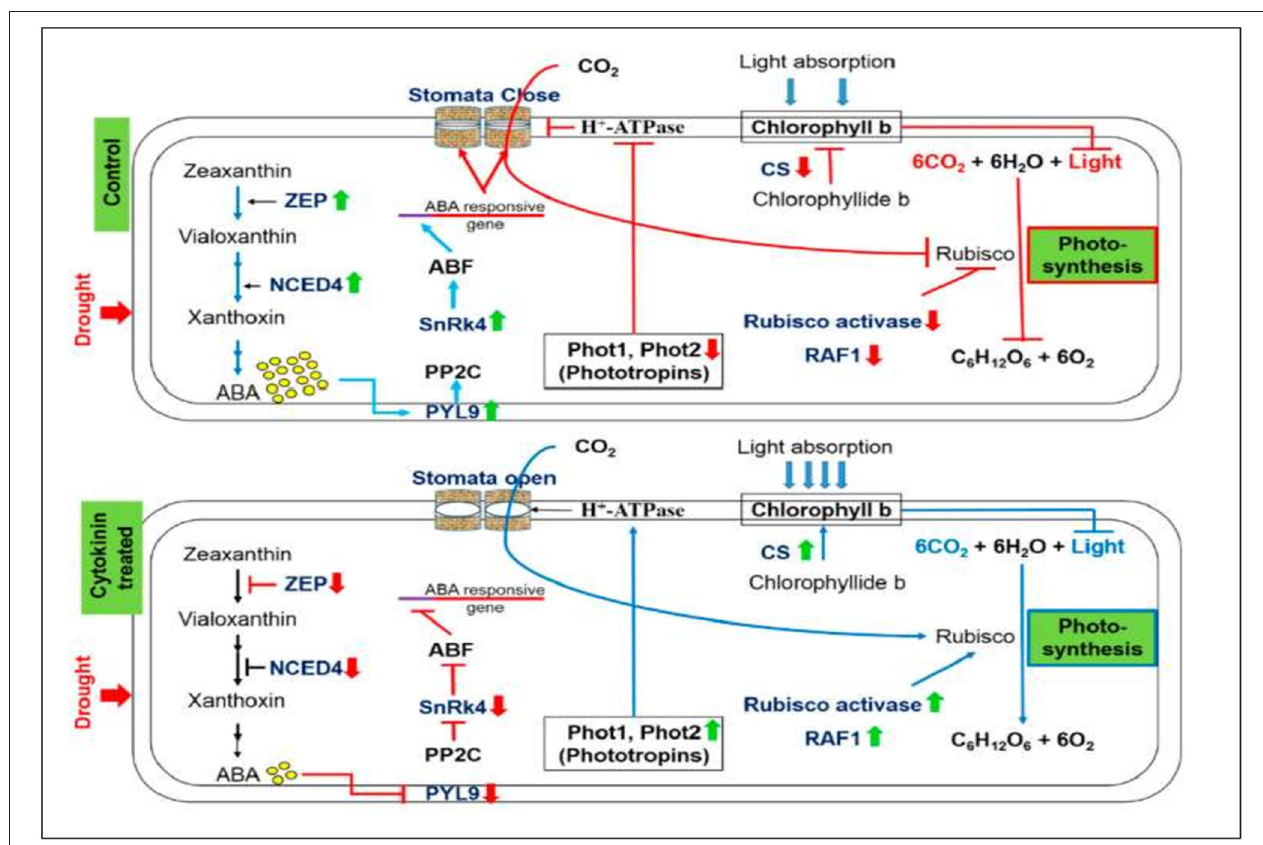
FIGURE 3 | The positive impact of synthetic CK on stomatal conductance, contents of chlorophyll b, and the process of photosynthesis under severe drought stress. Up (green) and down (red) arrows are the symbolic representations of increase and decrease, respectively. ZEP, Zeaxanthin epoxidase; NCED, 9-cis-epoxycarotenoid dioxygenase; ABA, Abscisic acid; PYL9, Pyrabactin-like receptor 9; PP2C, Protein phosphatase type-2C; SnRK4, Sucrose non-fermenting-1-related protein kinase 4; ABF, ABA-responsive factor; Phot, Phototropin; CS, Chlorophyll synthase; RAF1, Rubisco accumulation factor 1 (Gujjar et al.,